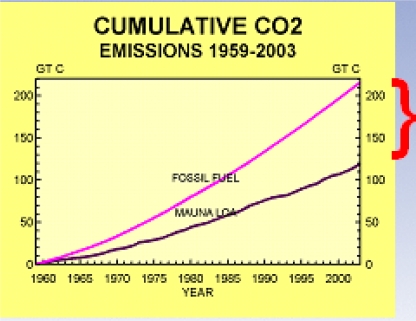
Measured Mauna Loa CO2 measurements showing 50% error versus the cumulative expected CO2 level from burning fossil fuels. Source: [8], Slide 14.